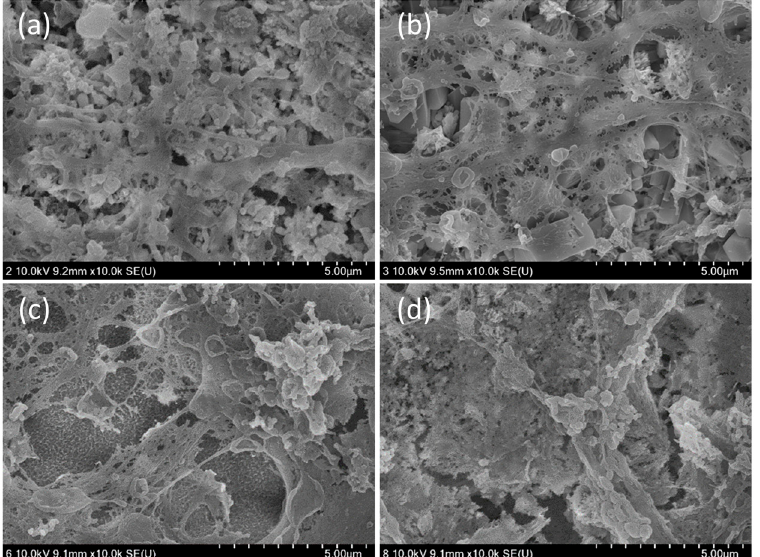
Figure 5. FE-SEM results of direct contact of the cells with each experimental sealer: ( a ) PZBS; ( b ) EndosealTCS; ( c ) Ceraseal; ( d )